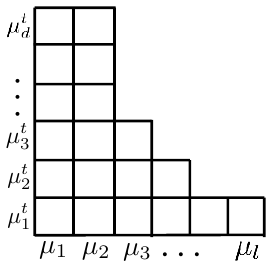
Figure 9 . The Young diagram we use in this